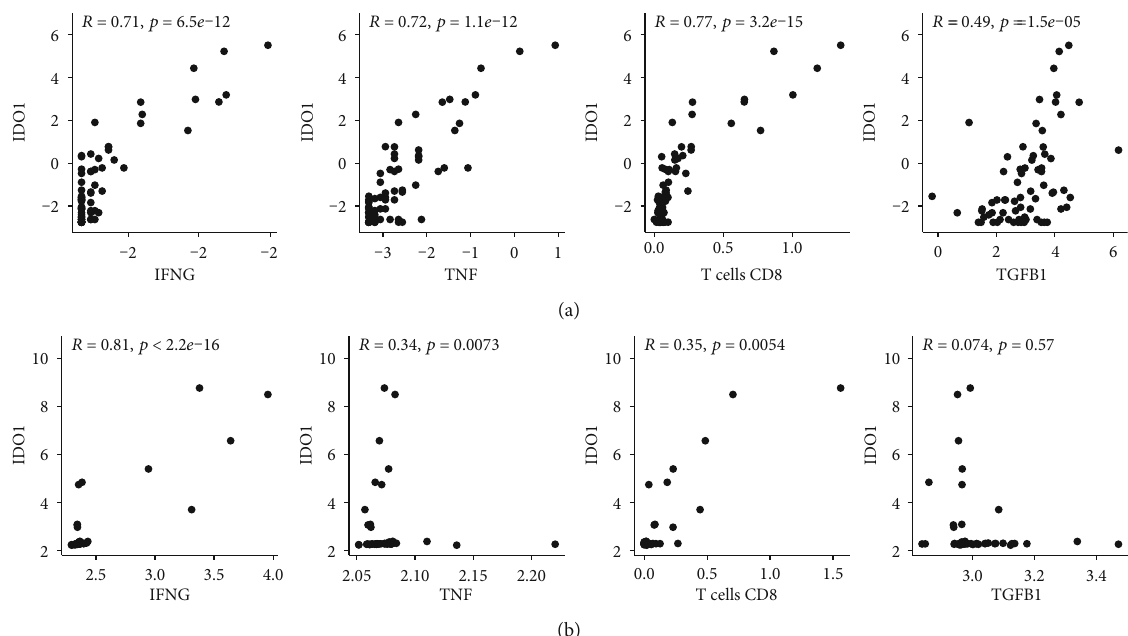
Figure 7: Correlation between IDO1 expression and IFNG, TNF, CD8+ T cell score and TGFB1 (left to right) in training cohort (a) and testing cohort (b). Displayed values are log transformed ( log2 ð x + 0 : 1 Þ ). R = 0.55, p = 7.9 e -07